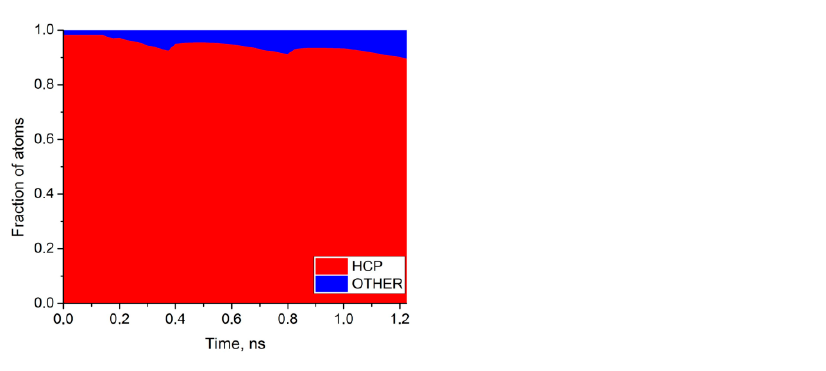
Figure 10. The time dependence of the number of atoms forming the hcp structure (red) and ones whose crystal lattice is different (blue).